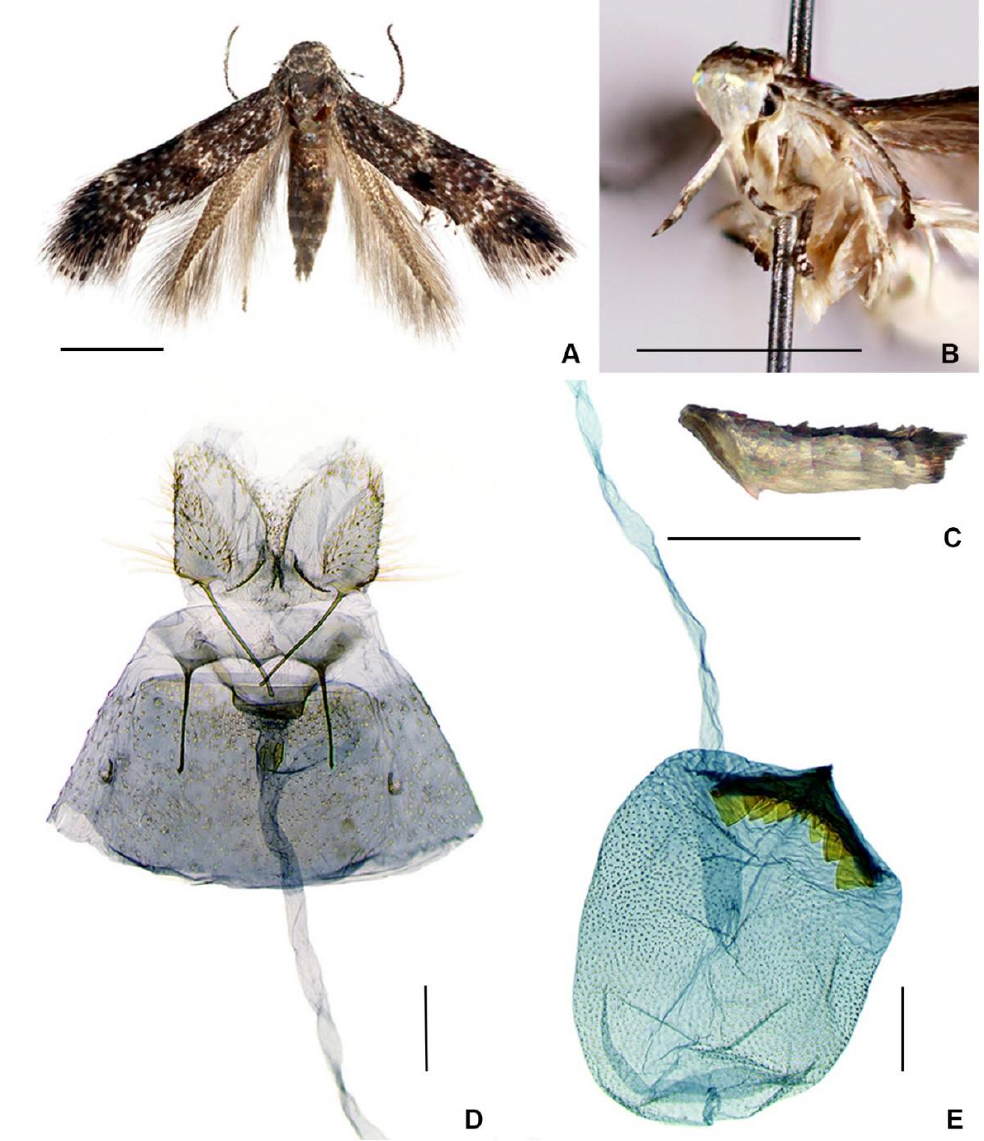
Figure 1. Elachista albisquamella , female: ( A ) adult; ( B ) head, fronto-lateral view; ( C ) abdomen, lateral view; ( D ) caudal part of genitalia; and ( E ) ductus and corpus bursae. Scale bars: ( A – C ) = 1 mm; ( D , E ) = 0.1